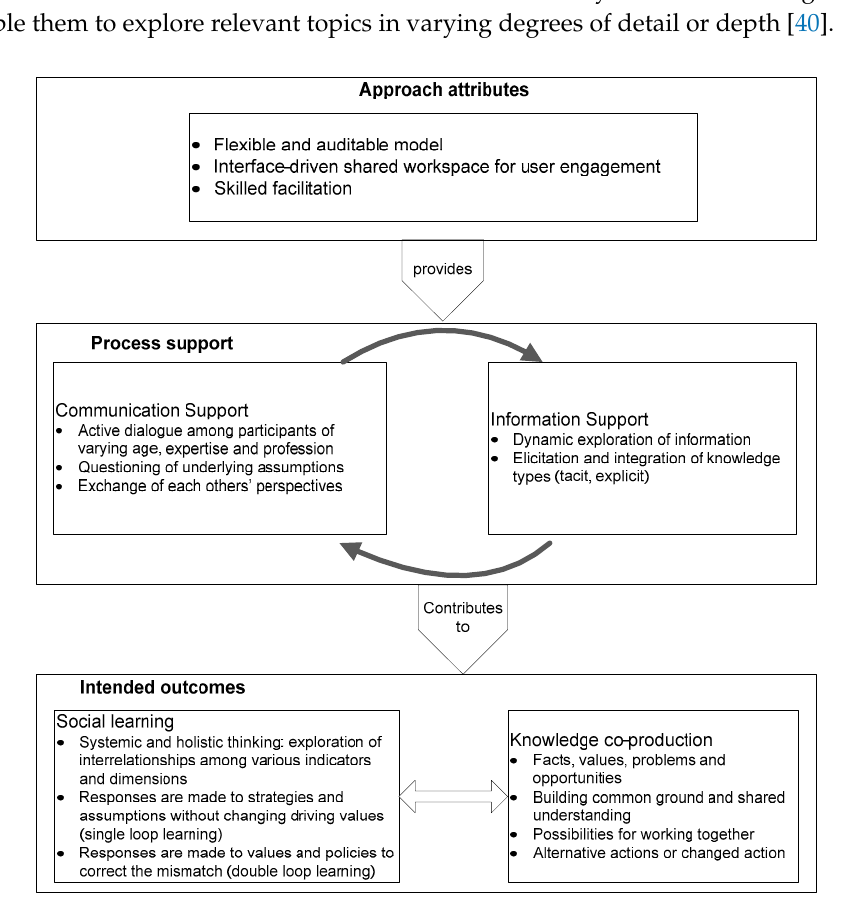
Figure 1. A conceptual framework for supporting social learning and knowledge co-production in cumulative burden assessment.